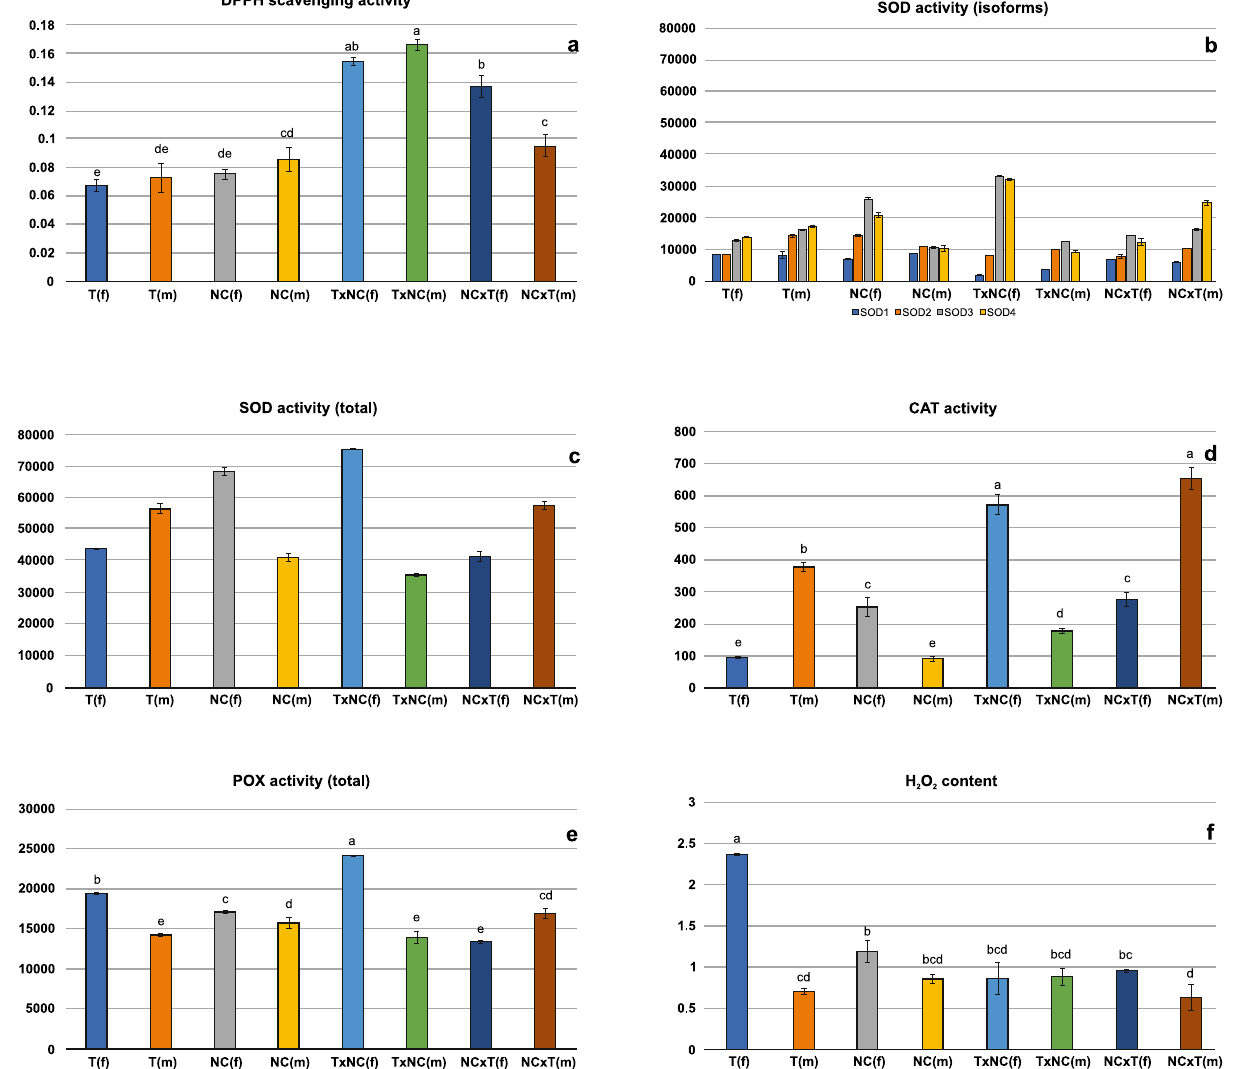
Figure 2. Analysis of selected physiological parameters in T, NC, T × NC and NC × T R. hastatulus forms. (f)—females, (m)—males; ( a ) DPPH free radical scavenging activity (in µmol dm −3 of Trolox equivalents); ( b ) activity of four detected SOD isoforms (a.u.); ( c ) total SOD activity (a.u.); ( d ) CAT activity (a.u.); ( e ) POX activity (a.u); ( f ) endogenous H 2 O 2 content (in μM H 2 O 2 /g